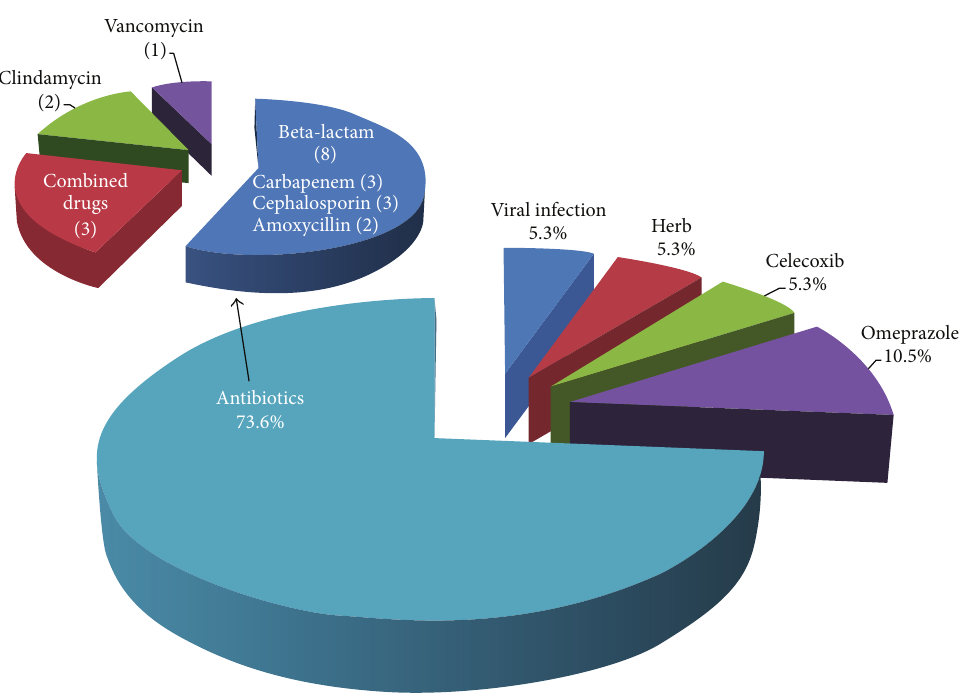
Figure 1: The etiology of acute generalized exanthematous pustulosis (AGEP) in this study.